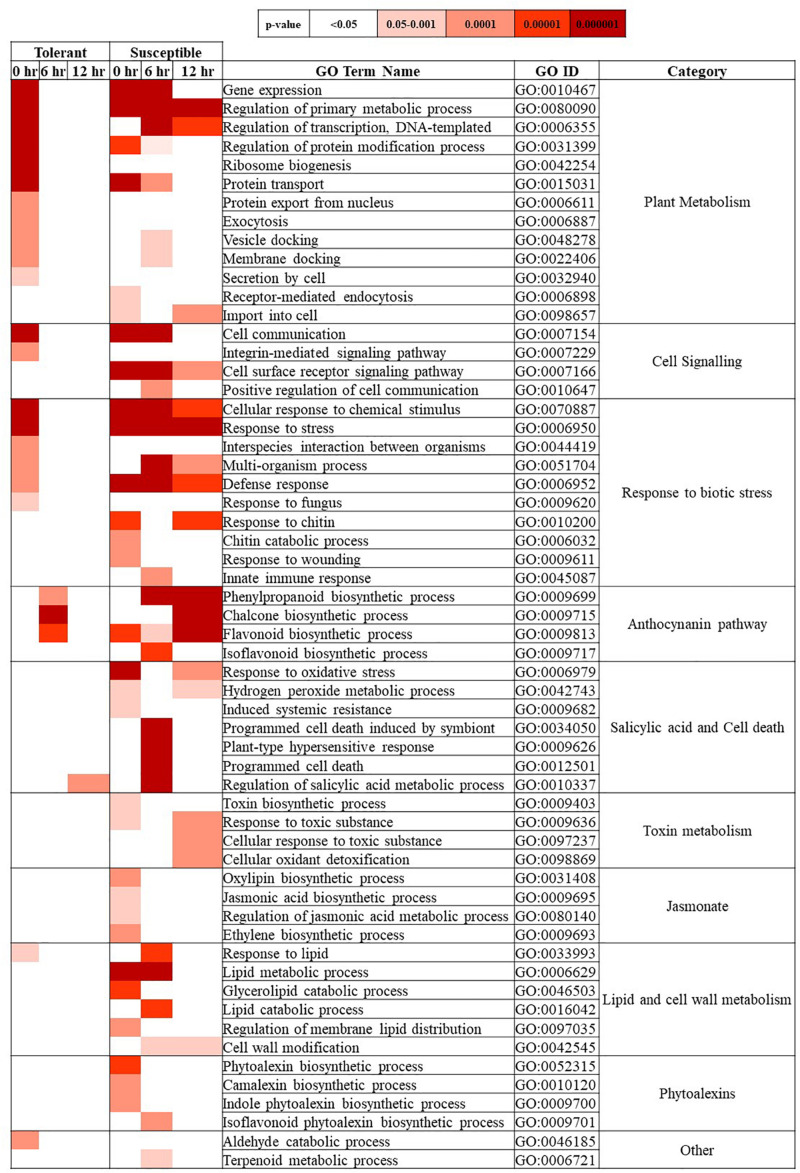
Biological process-GO terms over-represented in the Fsp inoculated treatment for tolerant and susceptible genotypes at 0, 6, and 12-h time points. The tone of colors in the heatmap denotes the p-value calculated using two-tailed Fisher’s exact test. Significantly over-represented GO terms showed a p > 0.05. p-values.